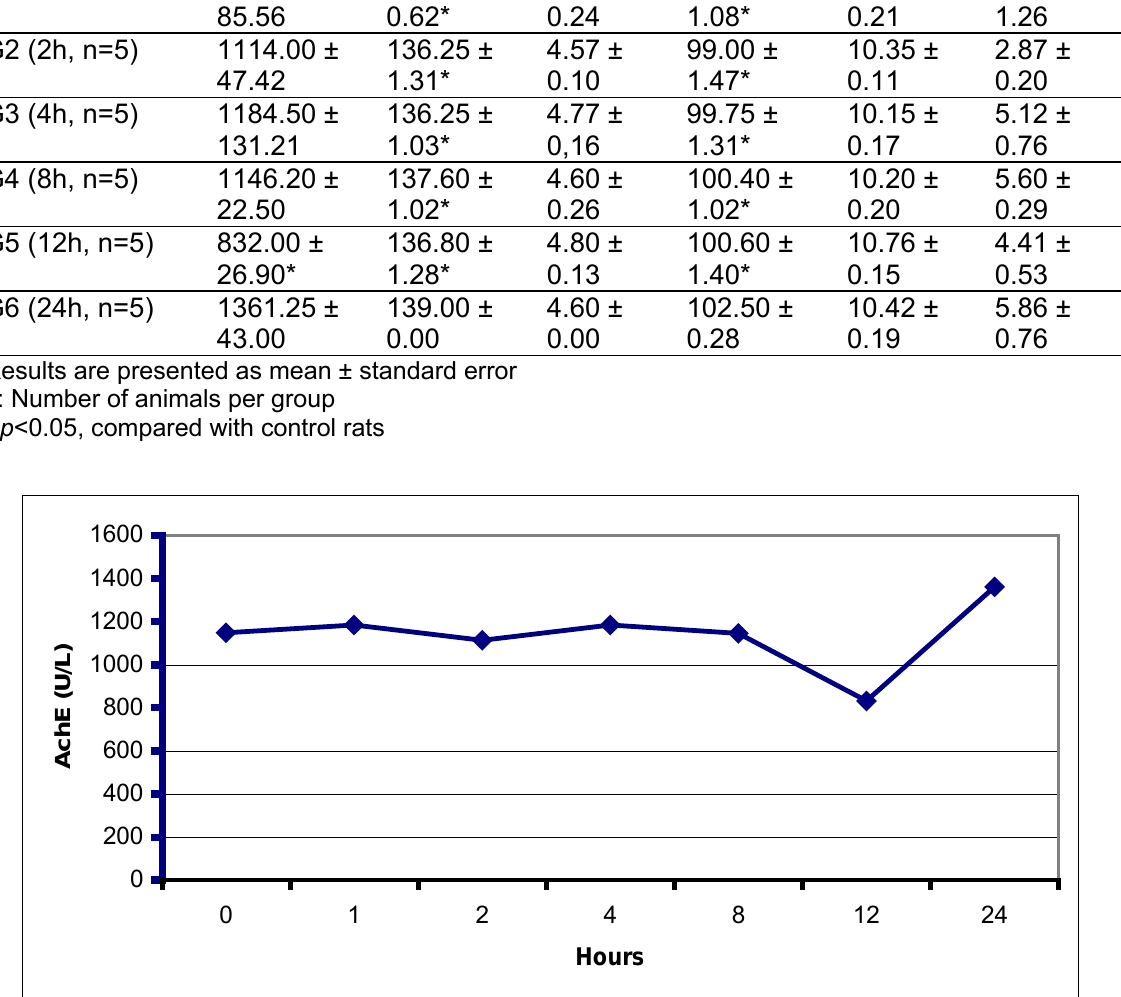
Figure 1: Acetylcholinesterase (AchE) activity throughout 24 hours after Androctonus crassicauda venom injection. There was a significant reduction on the 12 th